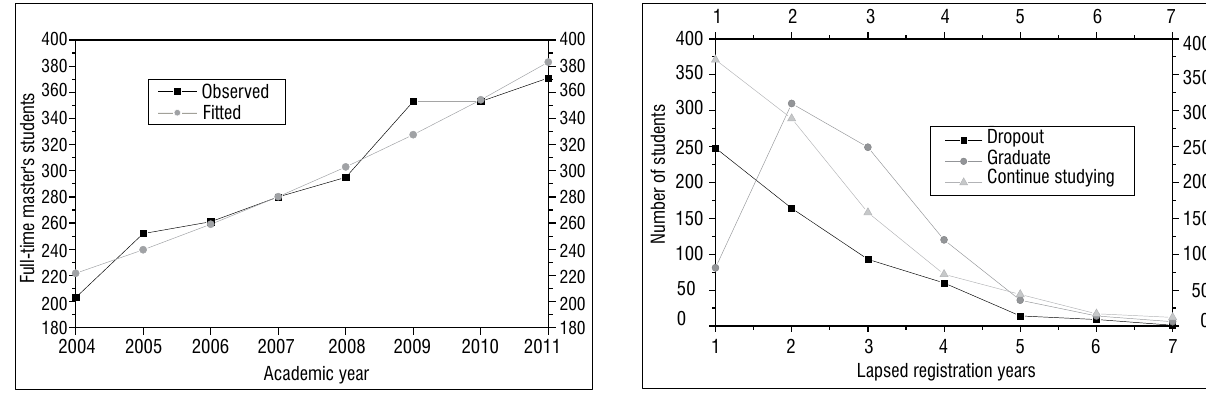
Number of master’s students with lapsed registration enrolled at University of KwaZulu-Natal between 2004 and